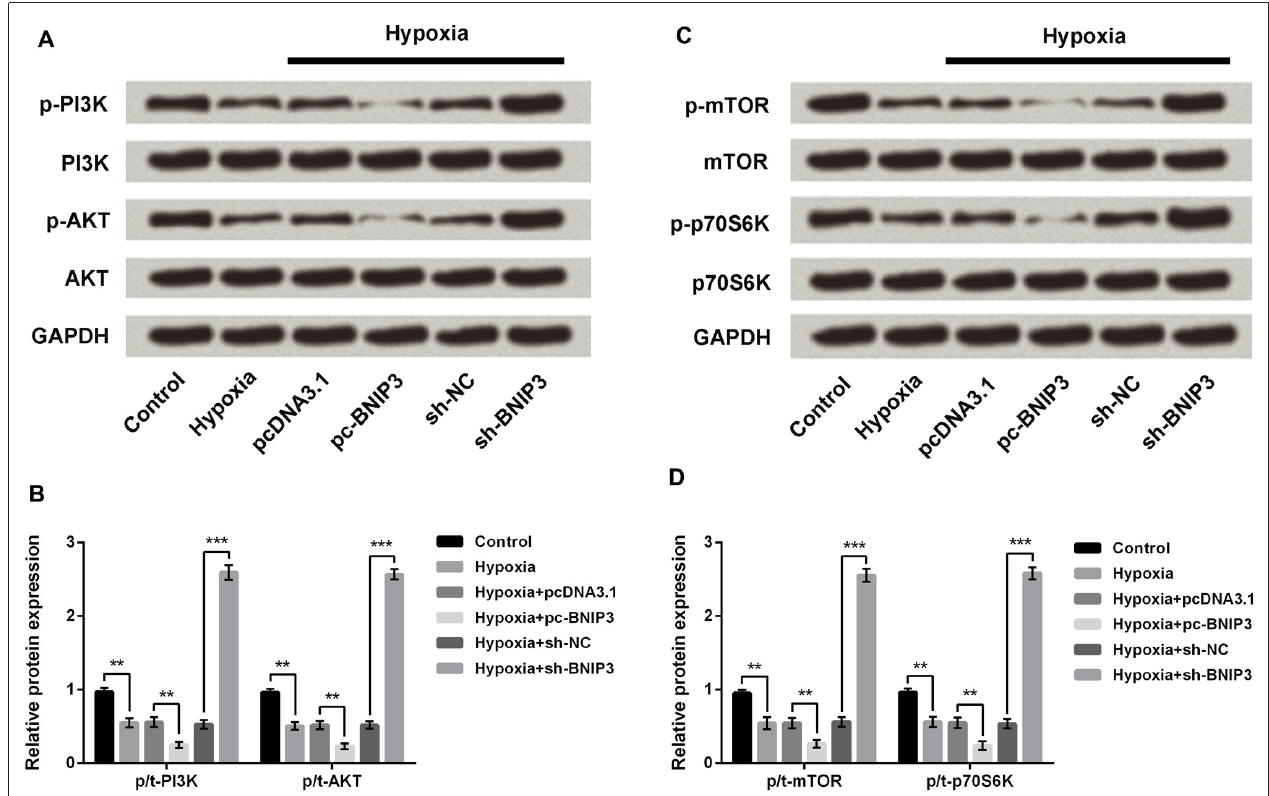
FIGURE 7 | BNIP3 affected the hypoxia-induced inhibition of the PI3K/AKT/mTOR signal pathway. (A,B) Western blotting analysis of factors associated with the PI3K/AKT pathway. (C,D) Western blotting analysis of factors associated with the mTOR pathway. Data presented are the mean ± SEM of at least three independent experiments. ∗∗ P < 0.01; ∗∗∗ P < 0.001. BNIP3, Bcl-2 adenovirus E1B 19 kDa-interacting protein 3; sh-NC, U6/GFP/Neo plasmid carrying a non-targeting sequence; sh-BNIP3, U6/GFP/Neo plasmid carrying sh RNA against BNIP3; pc-BNIP3, pcDNA3.1 carrying the full-length of BNIP3; PI3K, phosphatidylinositol 3-kinase; mTOR, mammalian target of rapamycin.